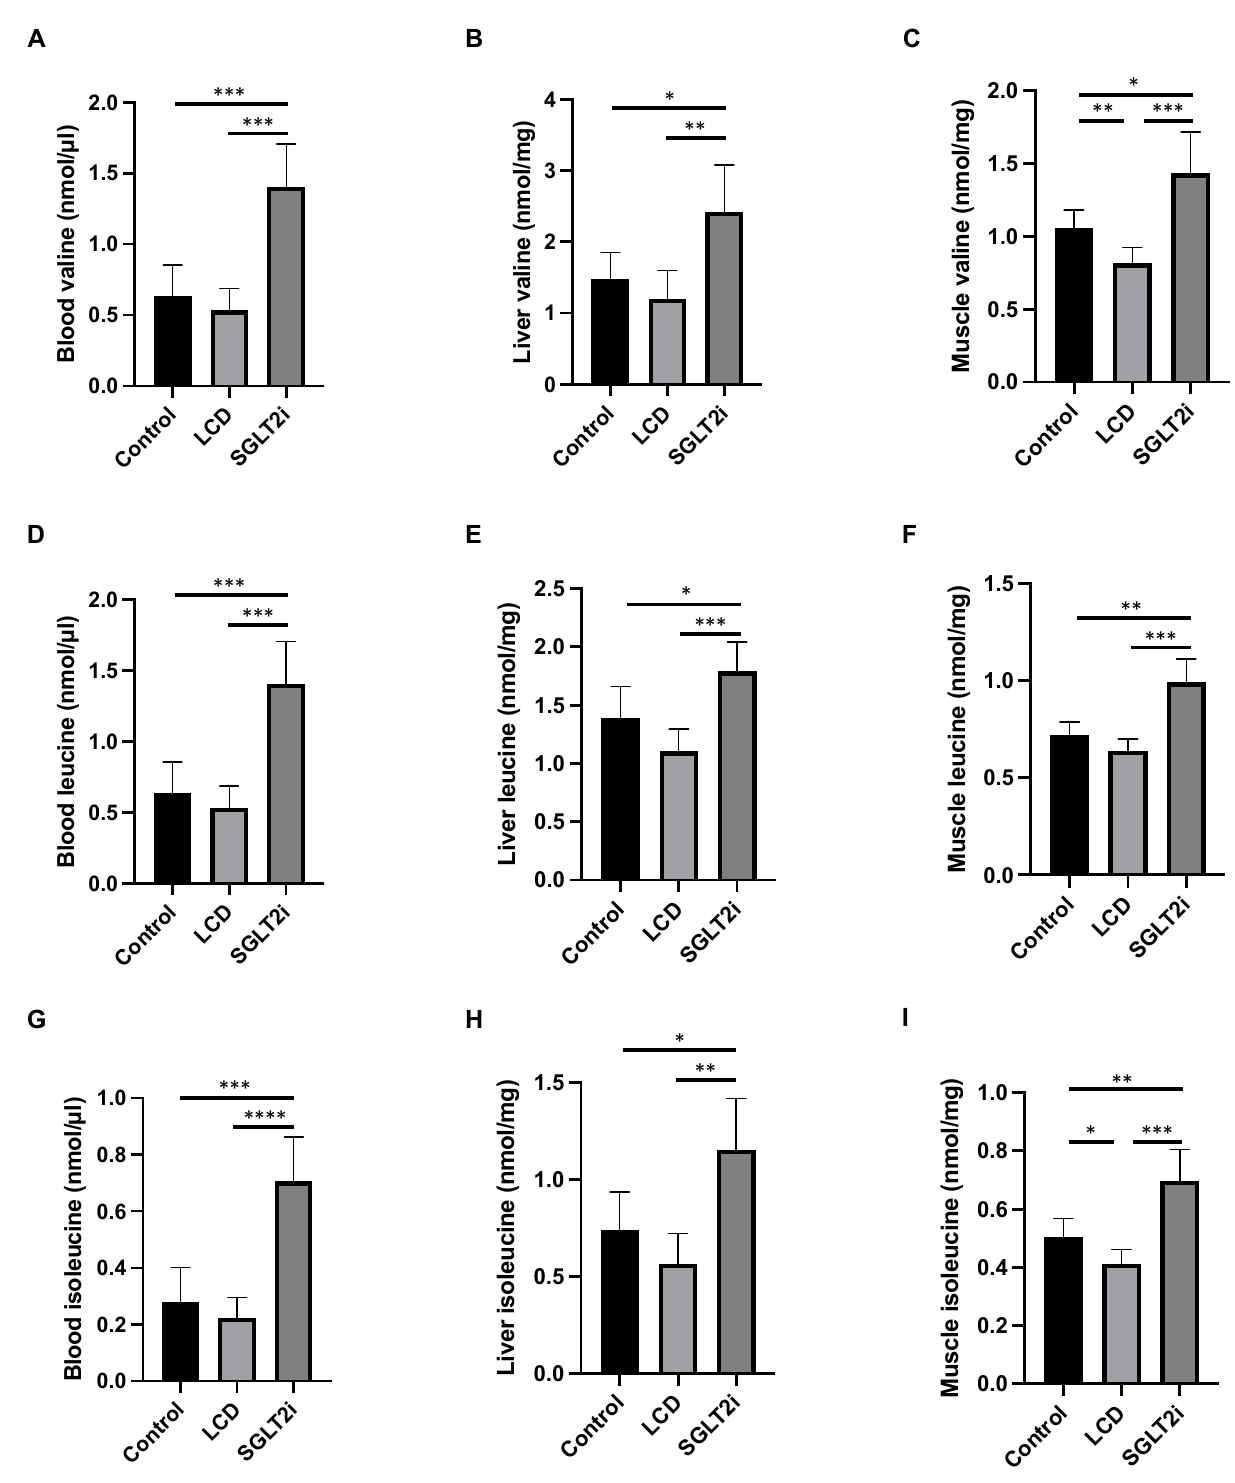
Figure 3. The amino acid concentrations in the sera, liver, and muscle. Concentration of valine in ( A ) serum, ( B ) liver, and ( C ) muscle. Concentration of leucine in ( D ) serum, ( E ) liver, and ( F ) muscle. Concentration of isoleucine in ( G ) serum, ( H ) liver, and ( I ) muscle. Data are mean ± SD. Statistical analyses were conducted with ANOVA. * p < 0.05, ** p < 0.01, *** p < 0.001, and **** p < 0.0001.